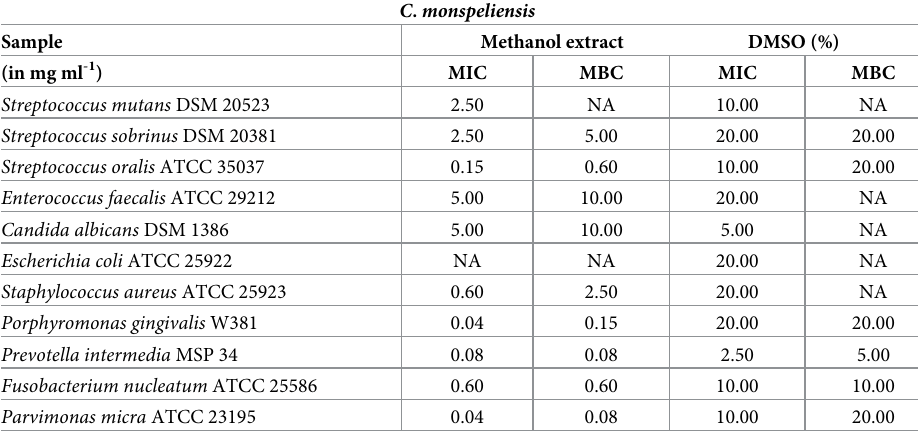
Table 8. Antimicrobial activity in mg ml -1 of C . monspeliensis methanol extract.